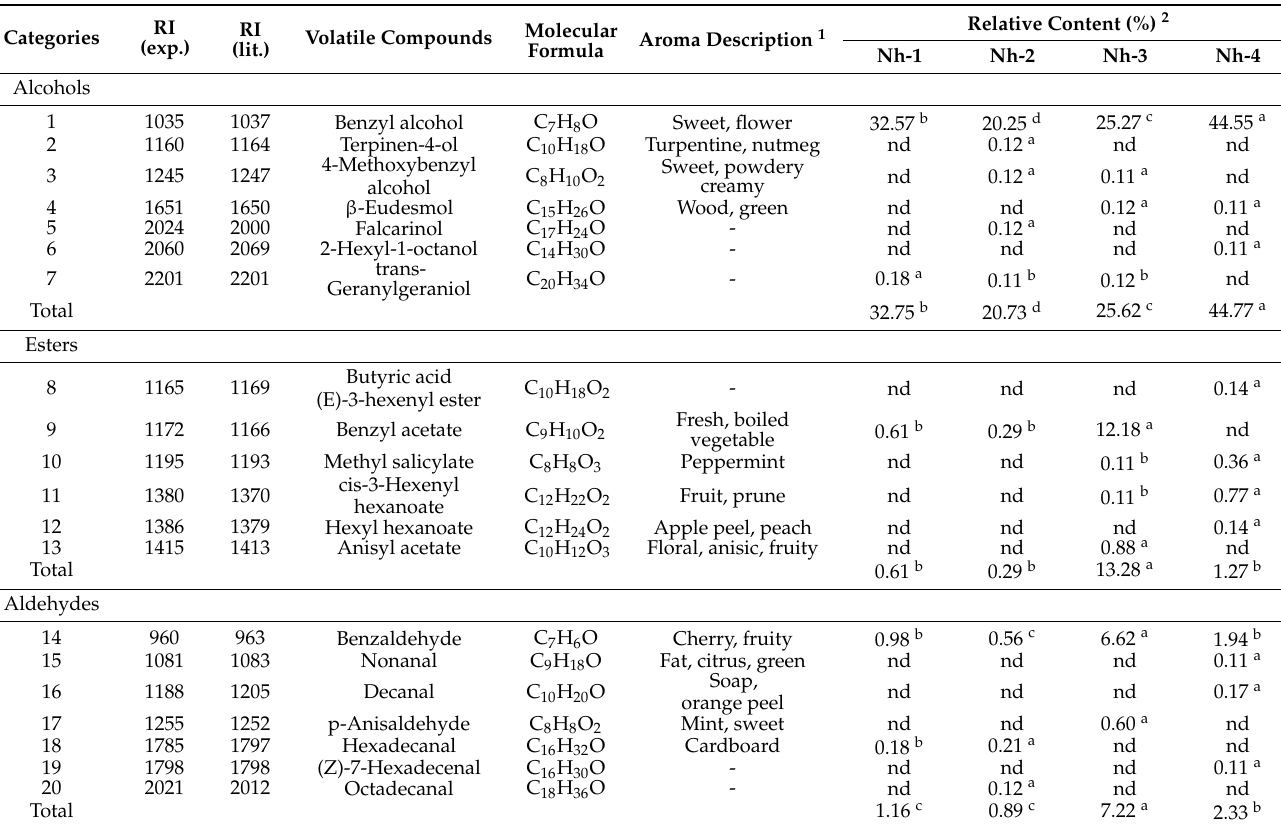
Figure 4. GC-MS total ion chromatograms (TICs) for the volatile chemical profiles of N. hybrid . Table 1. Volatile compounds released from the flower petals of N. hybrid Table 1. Volatile compounds released from the flower petals of N. hybrid.